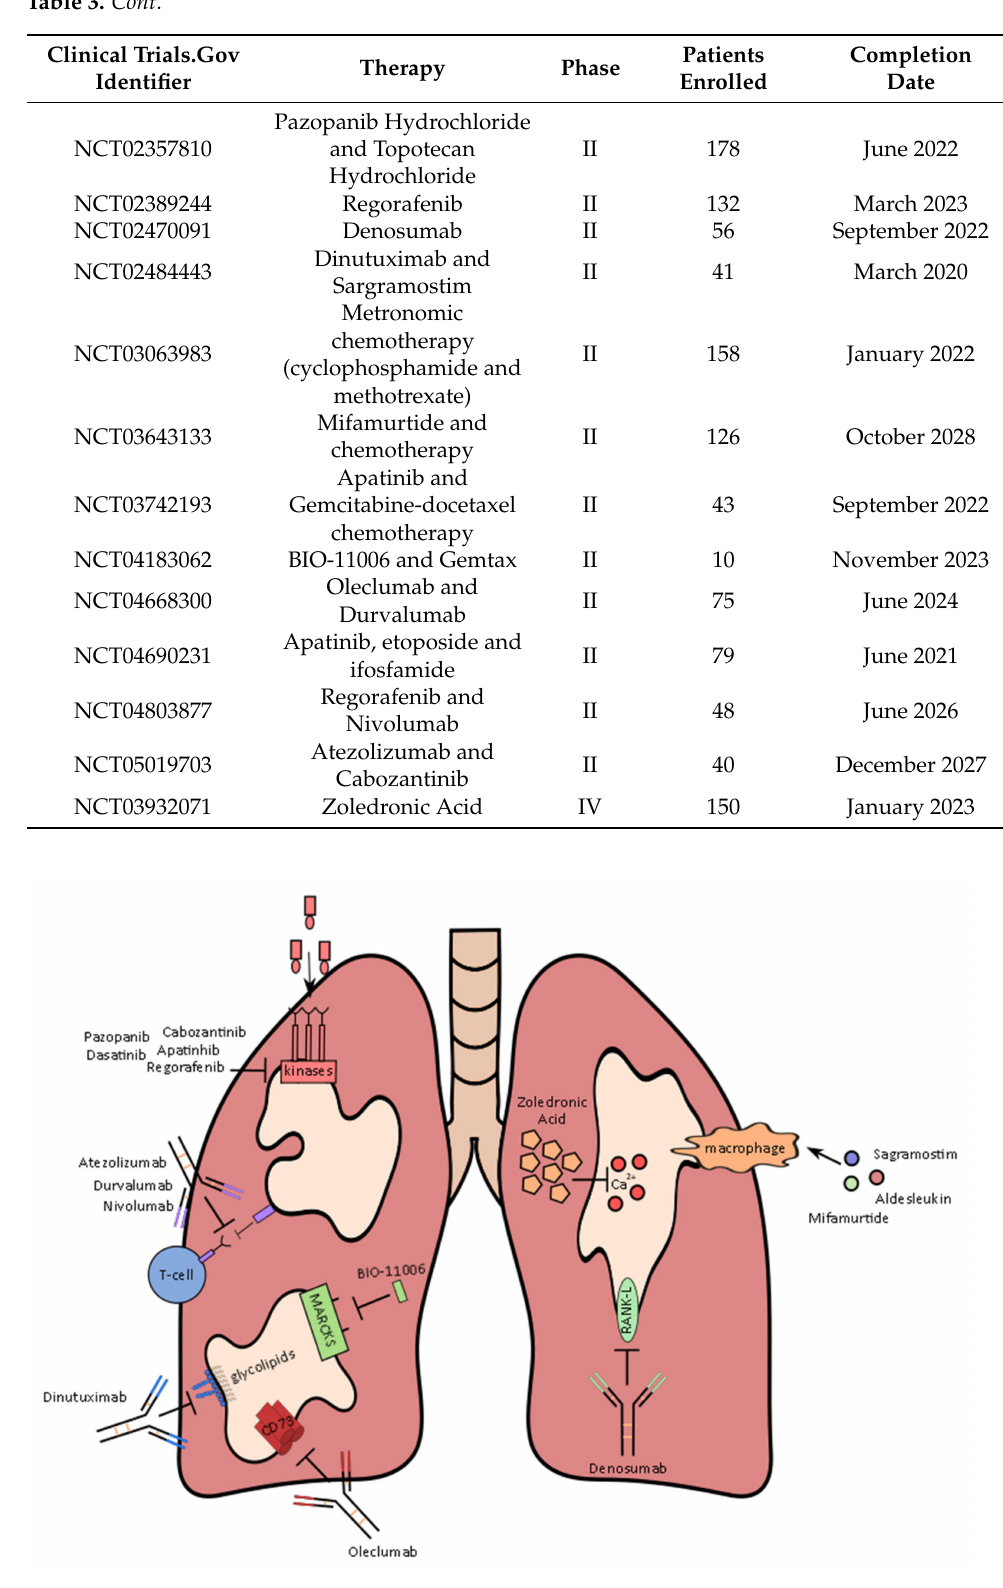
Figure 1. Therapies and their mechanism of action currently being evaluated to treat metastatic osteosarcoma in clinical